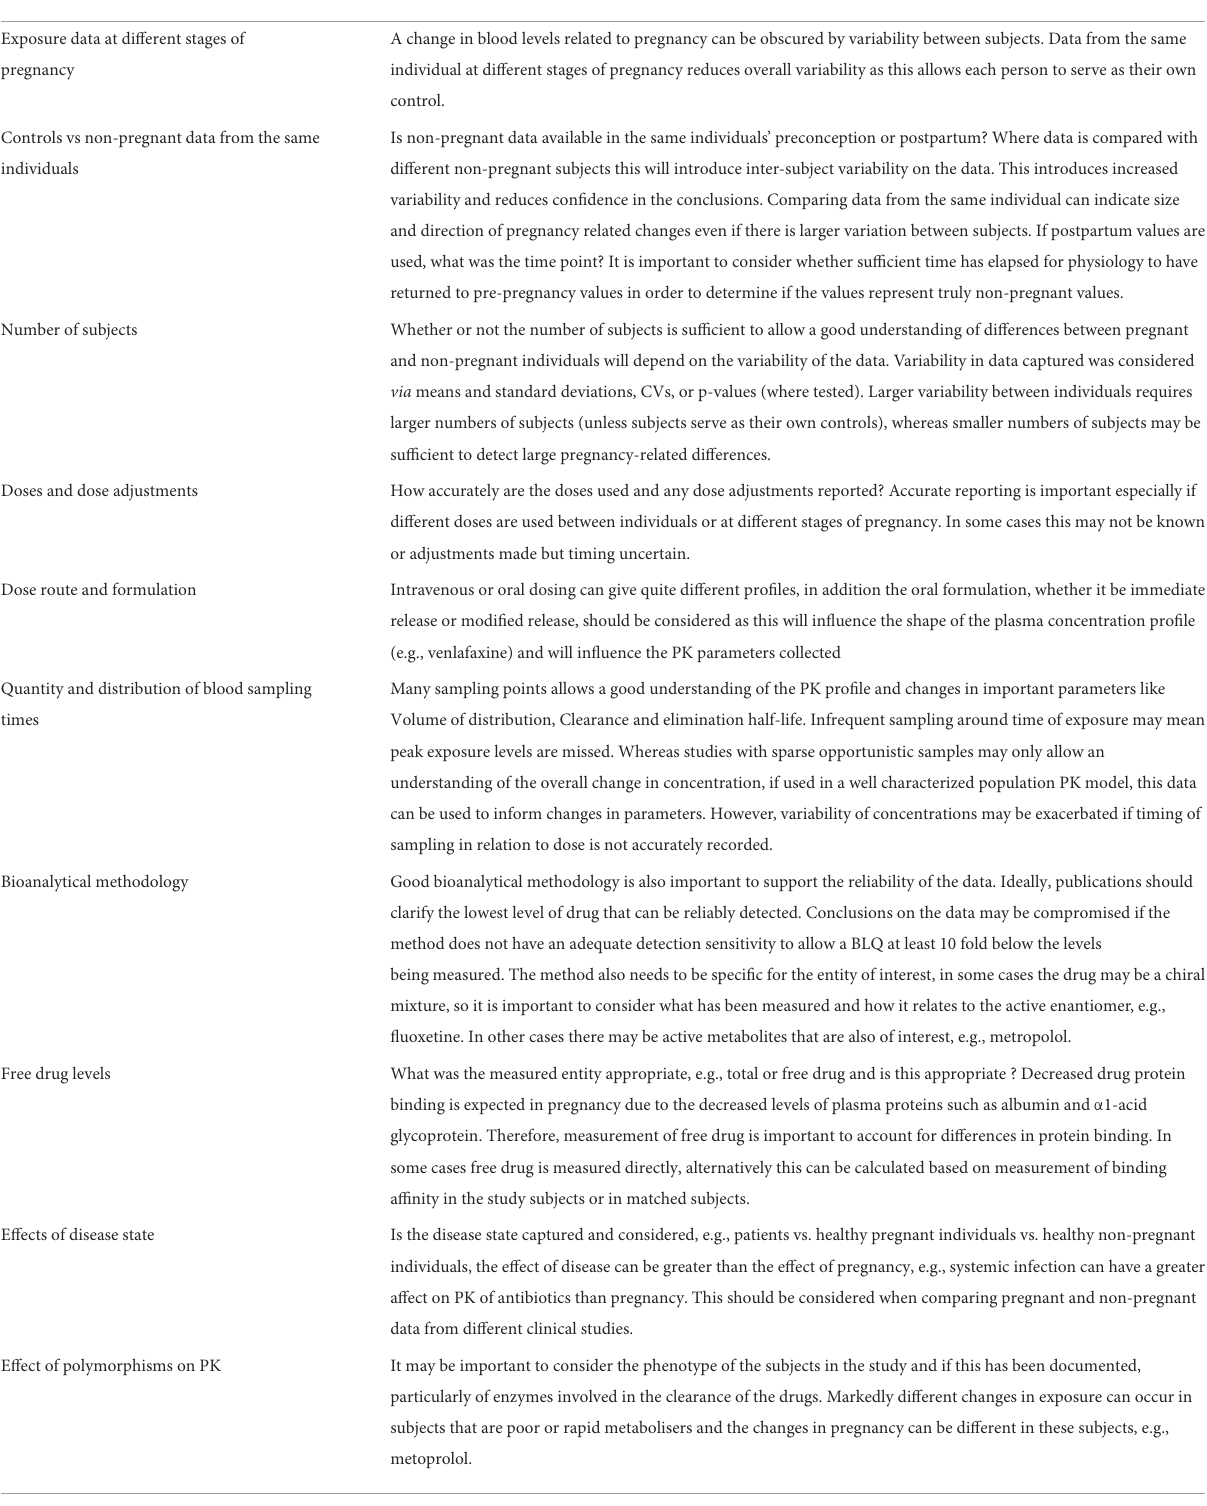
TABLE 2 Study design methodology factors which may affect reliability of PK